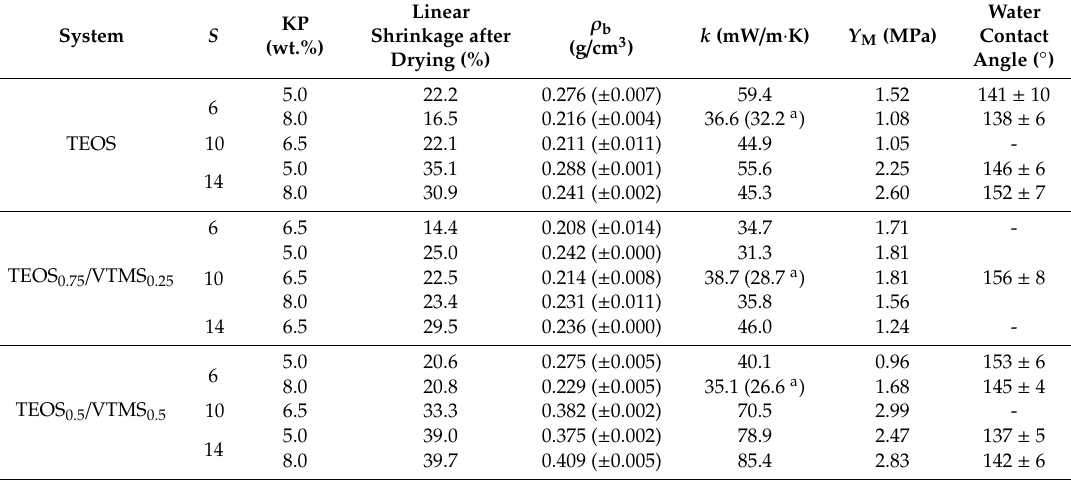
Table 1. Properties of KP-reinforced silica aerogel composites developed in this work.